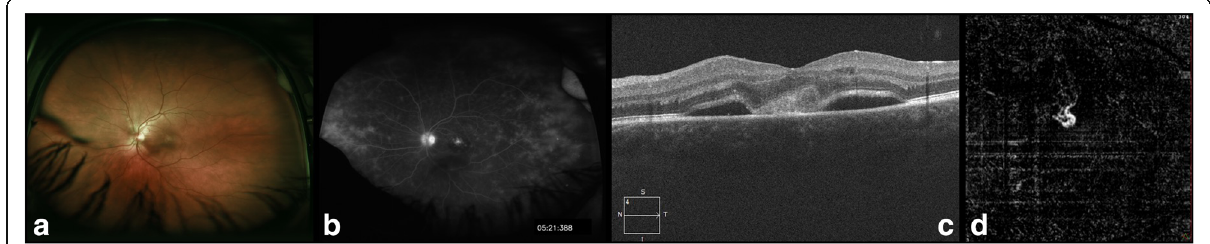
Fig. 2 Inflammatory choroidal neovascular membrane. The left eye of a patient with posterior uveitis ( a ) does not show retinal or choroidal lesions on fundus photography, but RPE mottling in the foveal area. Fluorescein angiography illustrates retinal vascular leakage ( b ) in the extreme periphery and an area of focal leakage superior to the fovea. This corresponds to subretinal hyperreflective material (SHRM) on the spectral domain OCT ( c ) and a type 2 choroidal neovascular membrane surrounded by sub-retinal fluid. The CNV is clearly identified in the outer retina on OCTA ( d